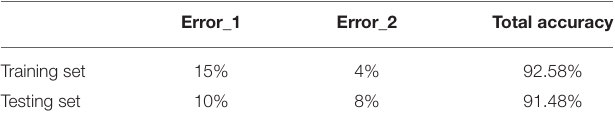
TABLE 4 | Prediction performance using TPA and PAI-1 as factors.